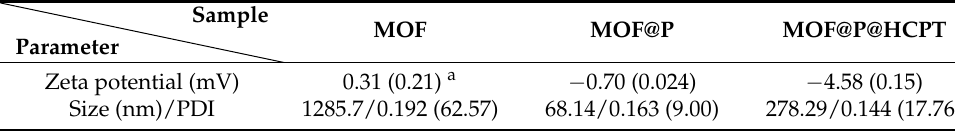
Table 5. Zeta potential and average particle sizes of the materials.